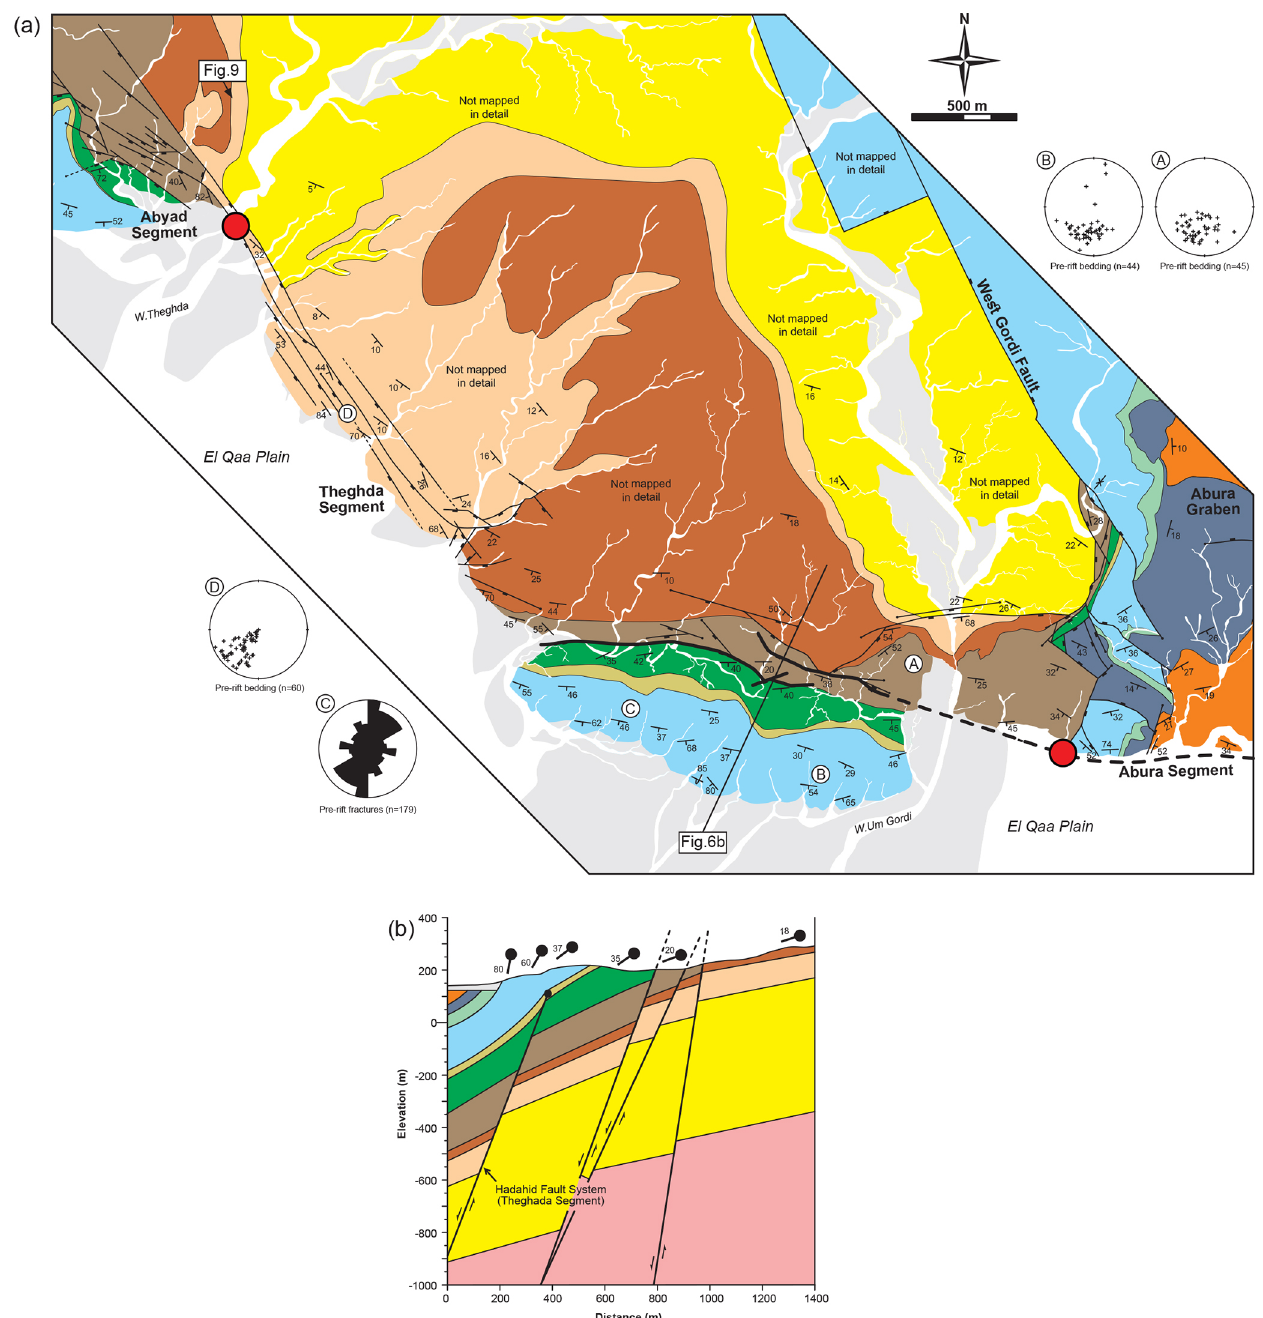
Figure 8. (a) Field map of the Theghda Segment of the Hadahid Fault System. Colour key to stratigraphic units is shown in Fig. 3a. Red dots indicate the approximate boundaries between the identified segments. Lower-hemisphere projection stereonets summarize the dip and dip direction of pre- and syn-rift bedding ( a–d ; location shown on map). Rose diagrams show the trend of fractures in pre-rift strata on the middle limb of the Thebes Formation-cored monocline. The location of the photograph shown in Fig. 9 and the cross section shown in (b) are indicated. (b) Down-plunge cross section across the Theghda